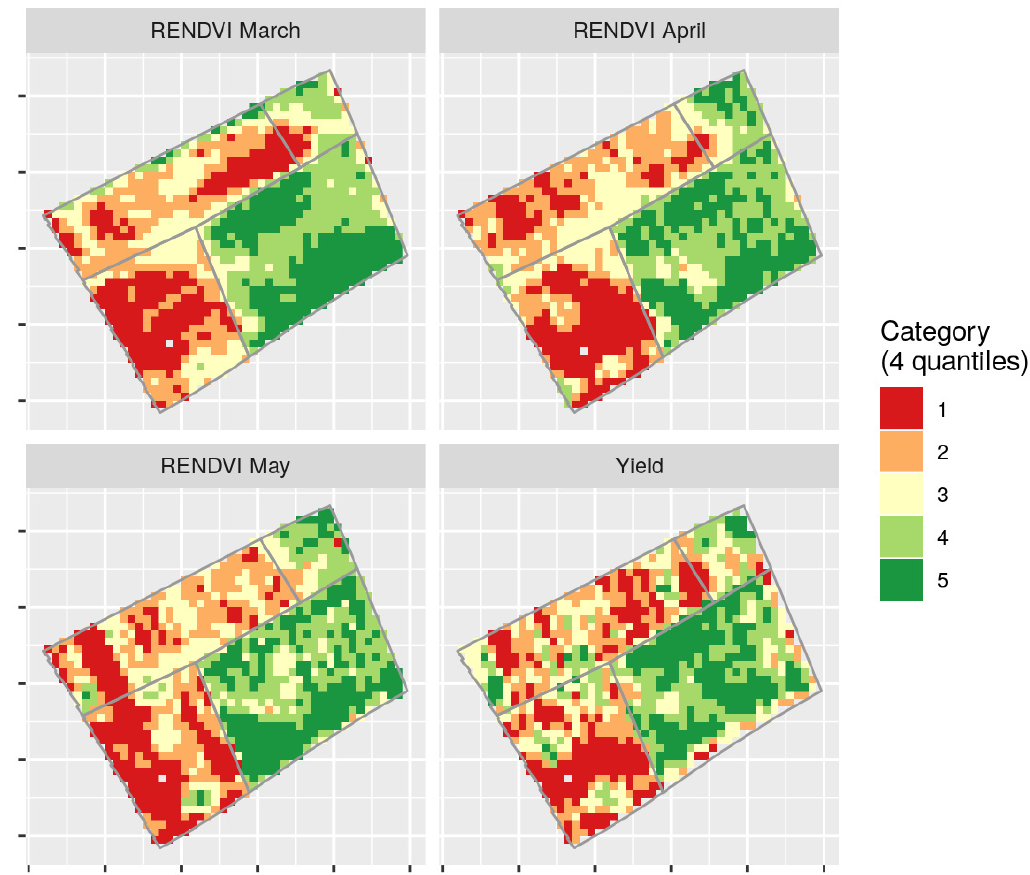
Figure 8. Class maps of RENDVI and winter wheat grain yield (classified into five groups of the same number of pixels, defined by four quantiles). See Figure 7 for details on acquisition and historical former field layout.